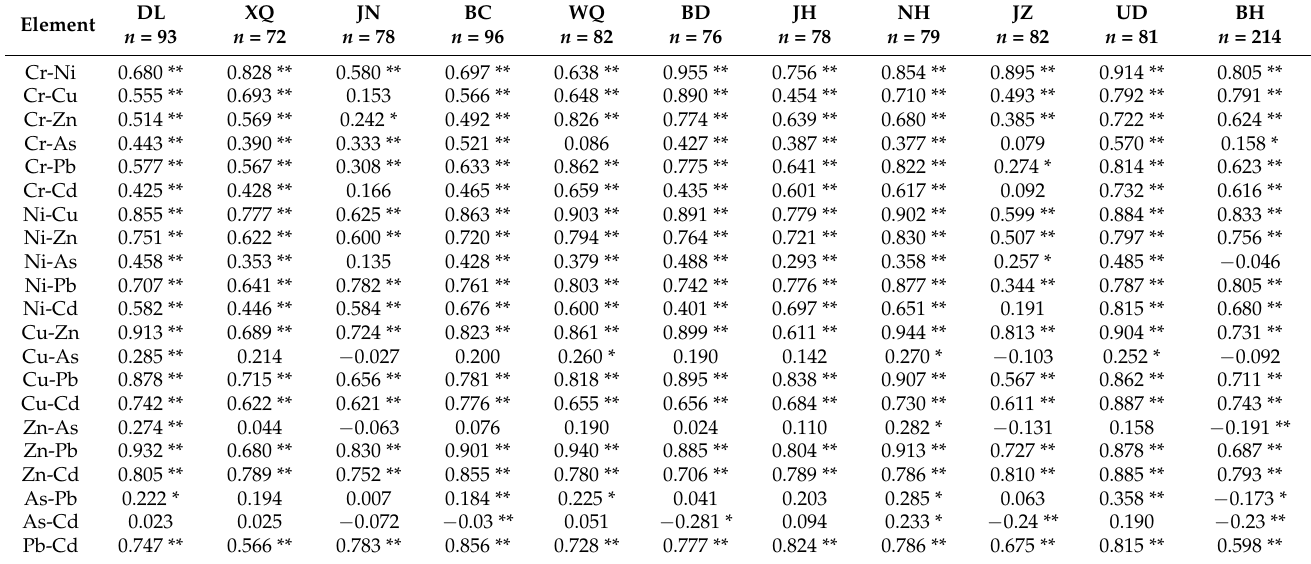
Table 7. Spearman correlation analysis of seven heavy metals in soils of different districts of